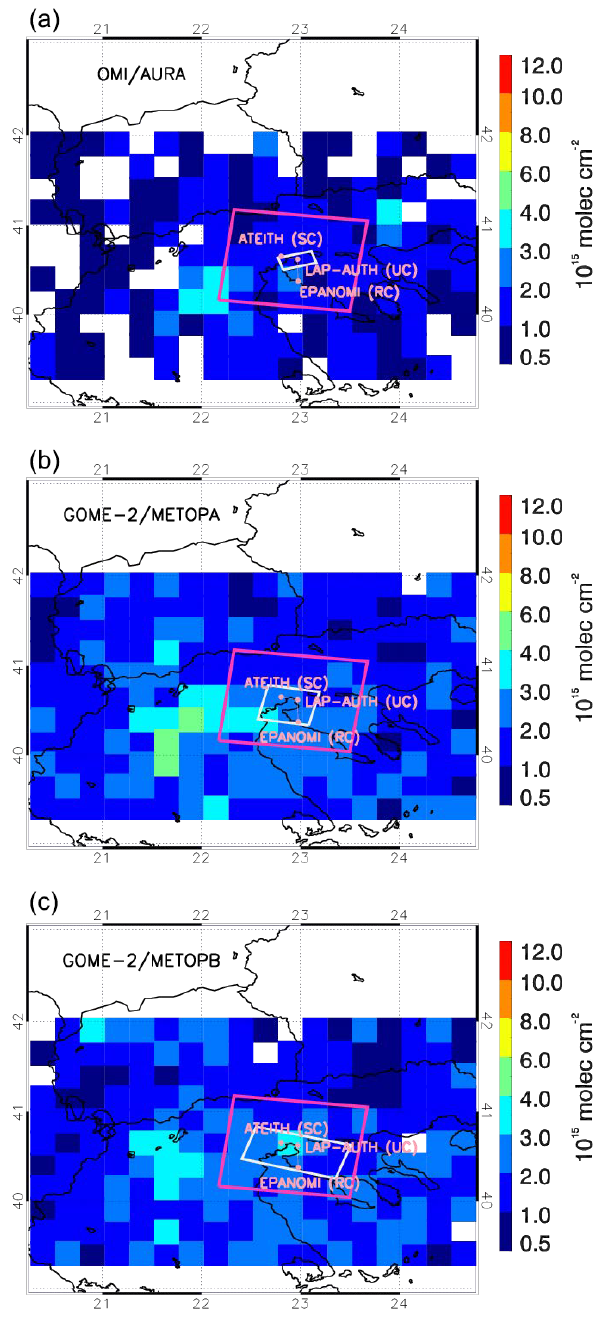
Figure 5. Maps of the tropospheric NO 2 spatial distribution aver- aged over the campaign period from OMI (a) , GOME-2A (b) and GOME-2B (c) observations. The white outlined areas represent the GOME-2 and OMI pixel sizes for 11 and 12 November 2014, re- spectively. The pink outlined areas represent the CAMx domain used in Fig. 6. Blank cells indicate lack of sufficient good-quality